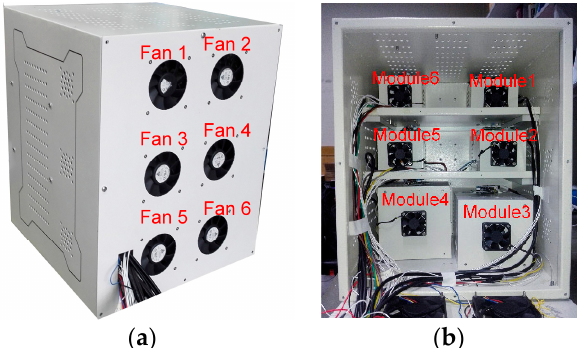
Figure 8. Mockup of the experiment platform. ( a ) Side view of the mockup; ( b ) Internal layout of the mockup.